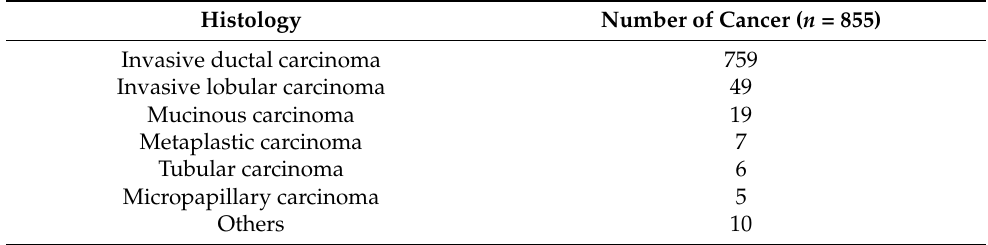
Table 2. Histologic type of breast cancer.